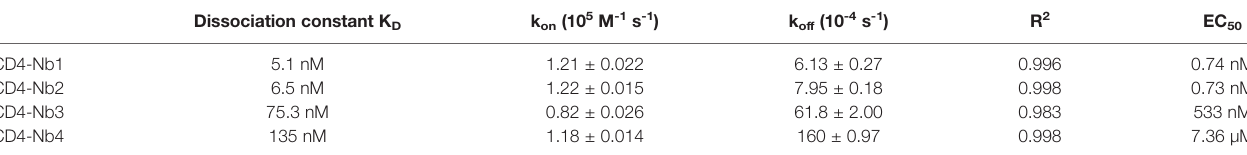
TABLE 1 | Summary of af fi nities (k D ) and association (k on ) and dissociation constants (k off and coef fi cient of determination R 2 ) determined by BLI (left side) and EC 50 values of fl ow cytometry (right side).